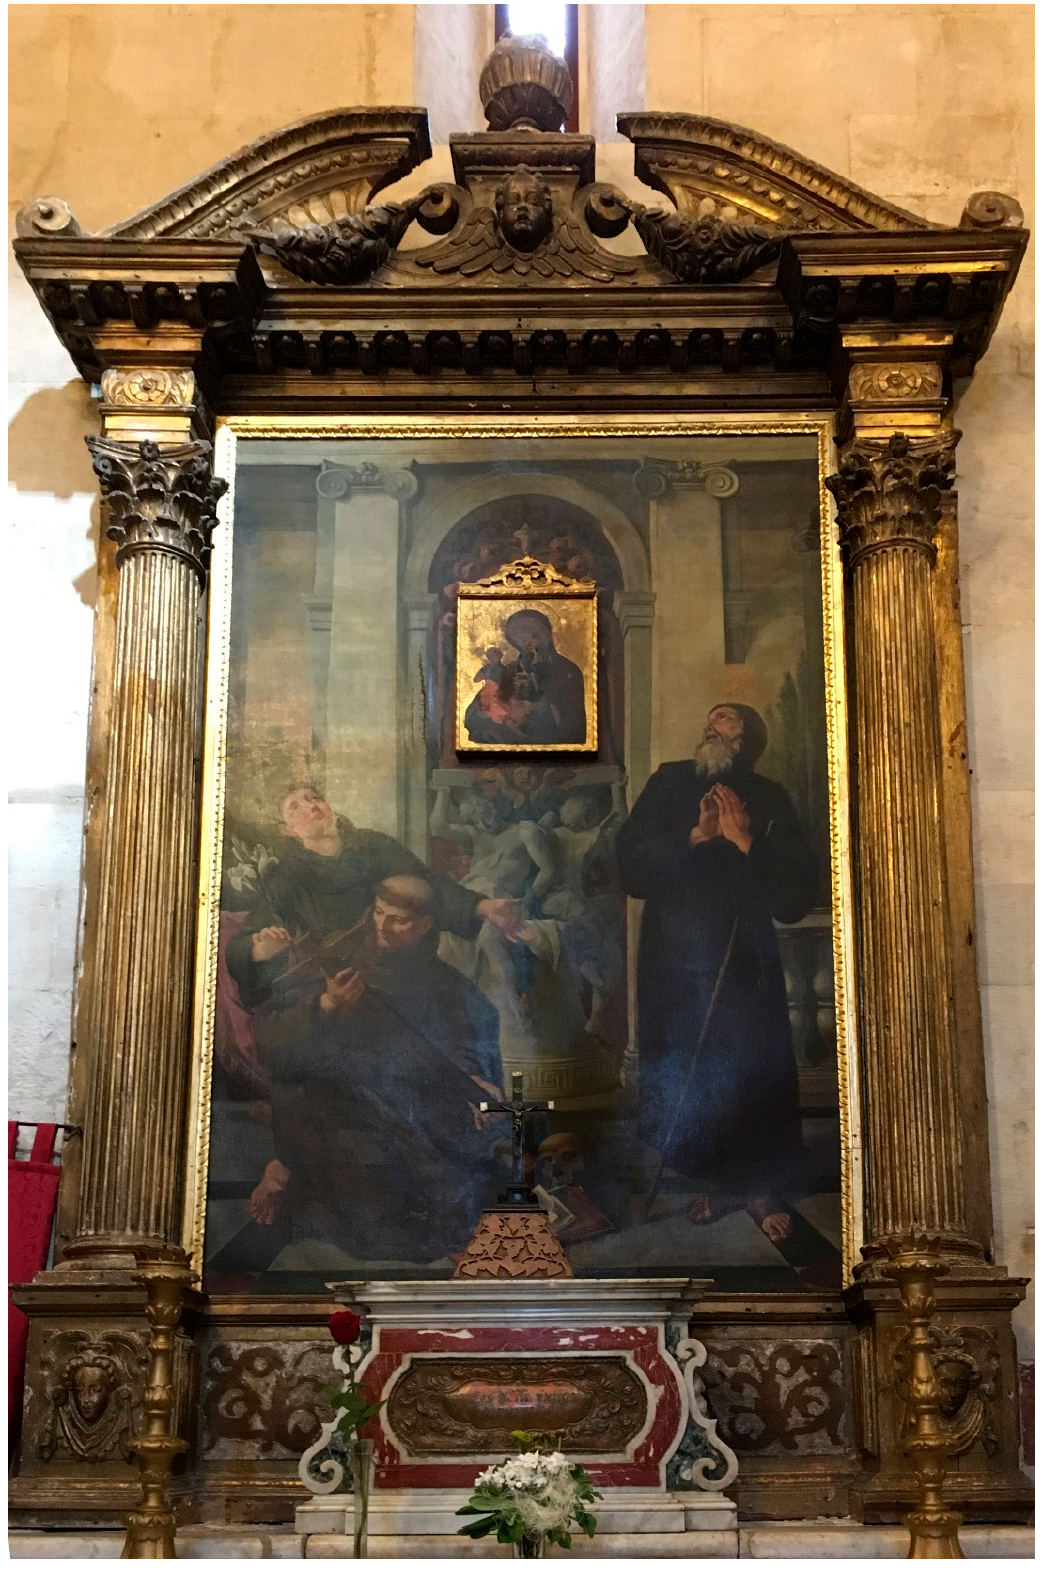
Figure 19. Icon of the Madre della Consolazione encased in an altarpiece by Giovanni Battista Agostino Pitteri, Trogir, Cathedral of Saint Lawerence (Katedrala Svetog Lovre) (photograph by the author).